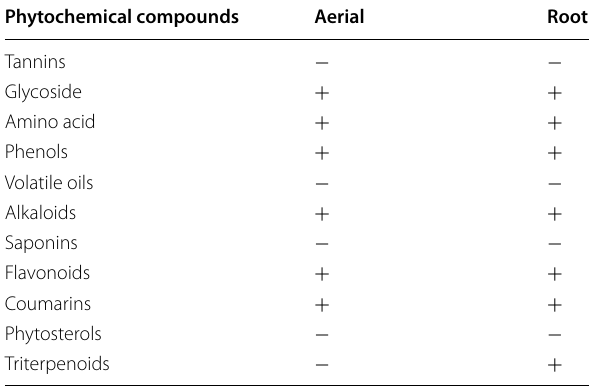
Table 4 Phytochemical screening of ethanolic extracts of aerial and